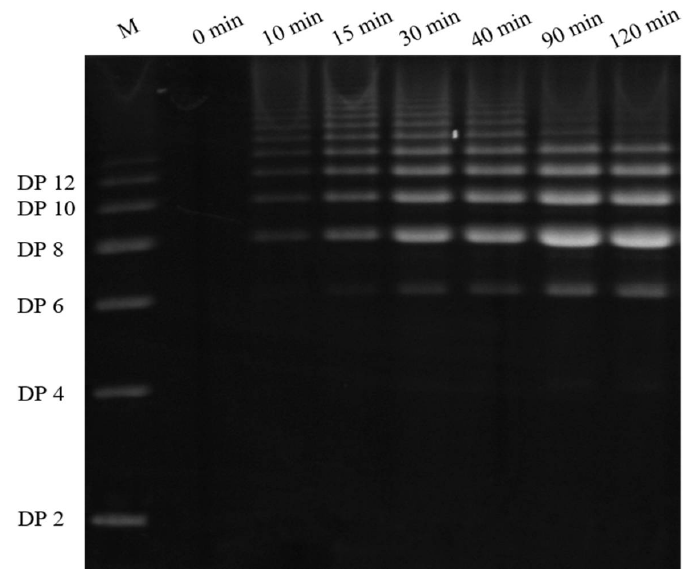
Figure 2. Time course of agar digestion analyzed by polysaccharide analysis using carbohydrate gel electrophoresis (PACE). M indicates the neoagaro-oligosaccharide standards. DP2—neoagaro-biose;